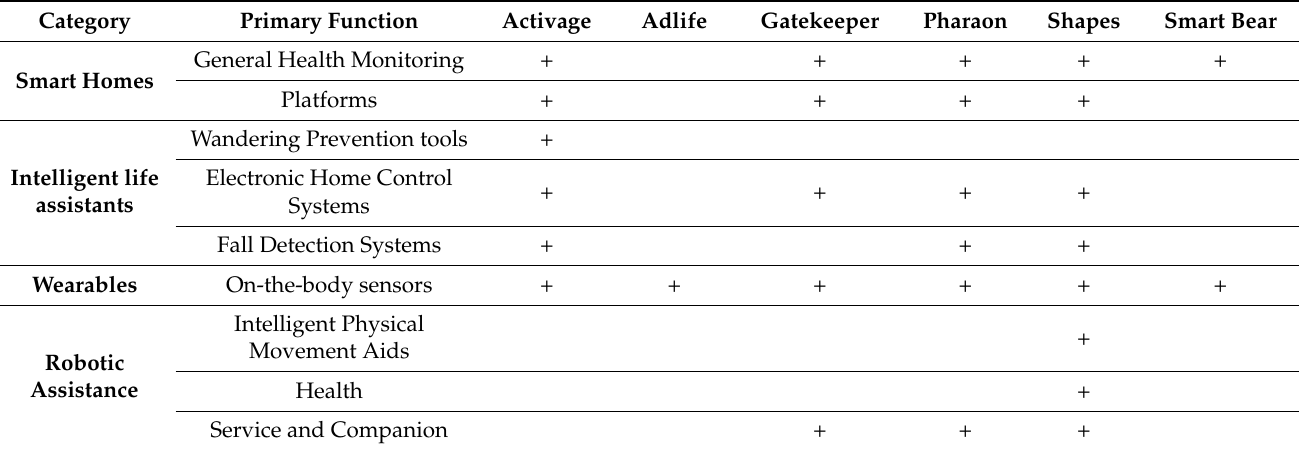
Table 2. Projects’ classification based on AAL